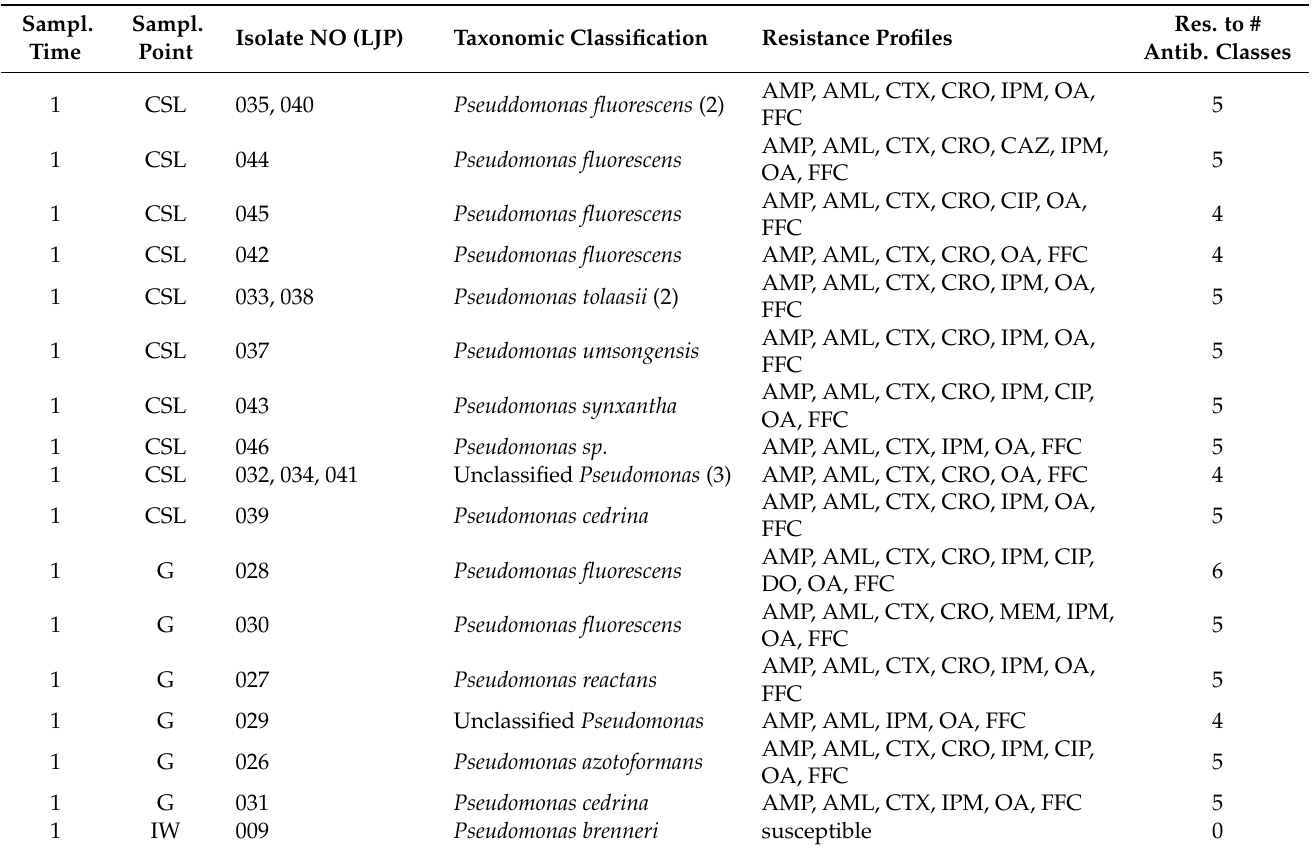
Table 2. Resistance profiles of the classified Pseudomonas population based on disk diffusion with corresponding breakpoint values (EUCAST 2022). All isolates are LJP, only isolate numbers are displayed in the columns. CSL; conveyor slaughter, G; gutting machine suction, IW; inlet water, HCK; head cutting knife, CSK; conveyor skinning, DS; drain slaughter, DF; drain filleting department, S1–5; skin five different fish, F1–5; Fillet five different fish, G1–5; gills of five different fish. The sampling times span a period of one